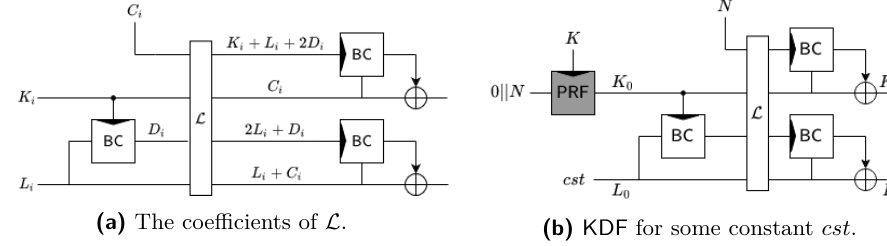
Figure 8: The Key Derivation Function ( KDF ) and our linear map L .